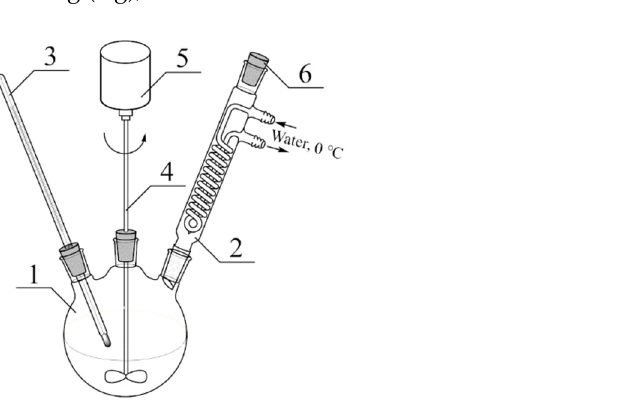
Figure 2. Schematic diagram of the three-necked flask for leaching. 1-three-necked flask, 2-con- densing return tube, 3-glass thermometer, 4-agitator, 5-electric motor, 6-plug.